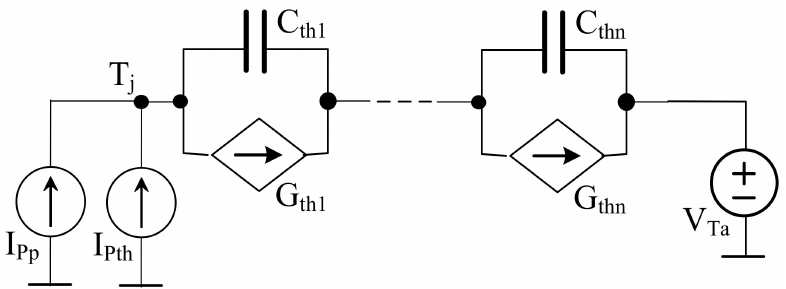
Figure 7. Network representation of a nonlinear thermal model of the electronic